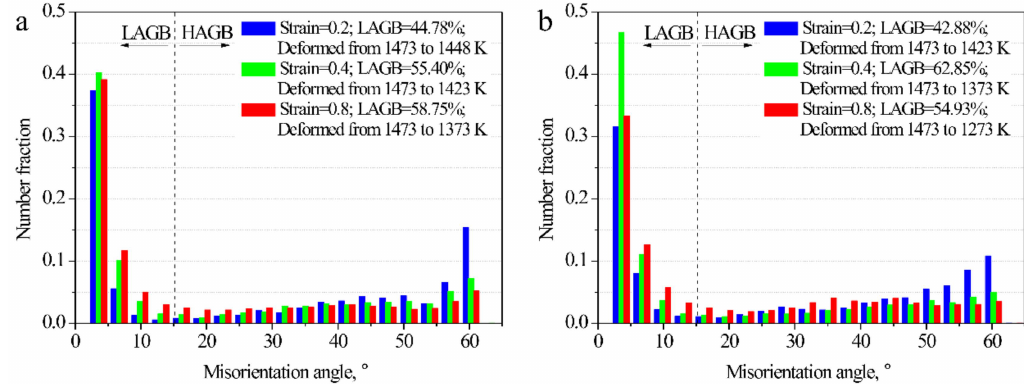
Figure 5. Distribution of misorientation angles of specimens deformed at 10 − 4 s − 1 with cooling rates of ( a ) 0.0125 Ks − 1 and ( b ) 0.025 Ks − 1